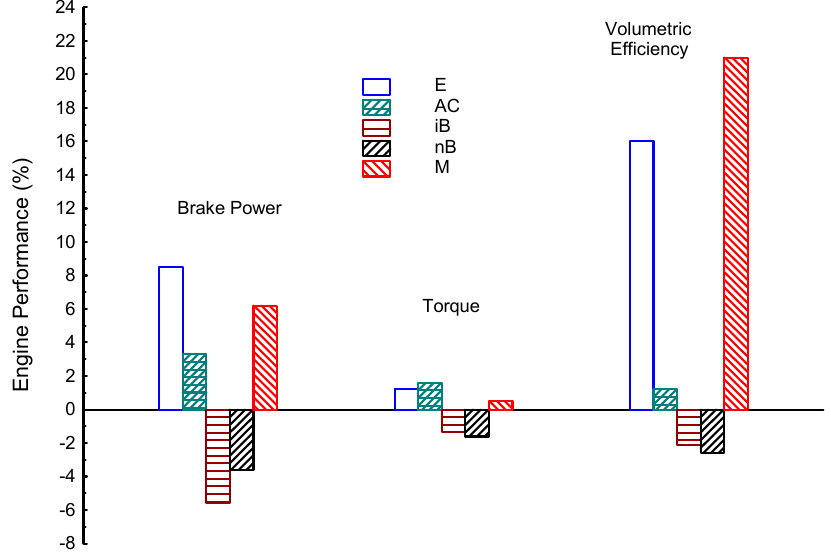
Figure 1. Comparisons of volumetric efficiency, torque, and brake power for ethanol (E), methanol (M), n-butanol (nB), i-butanol (iB), and acetone (AC) blended with gasoline and neat gasoline (baseline) in %.